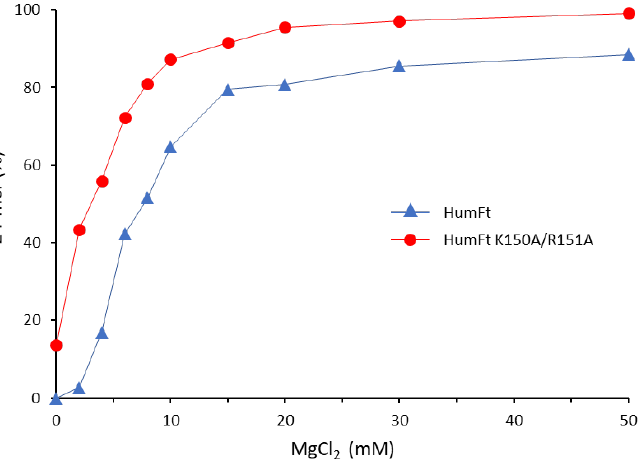
Figure 7. MgCl 2 effect on HumFtR150A/K151A assembly compared to HumFt. HumFtR150A/K151A in 150 mM HEPES buffer is dissociated at 15%. The addition of 50 mM MgCl 2 induces the complete closure of the protein cage (red line). At the same concentration of MgCl 2 , HumFt is still partially dissociated (blue